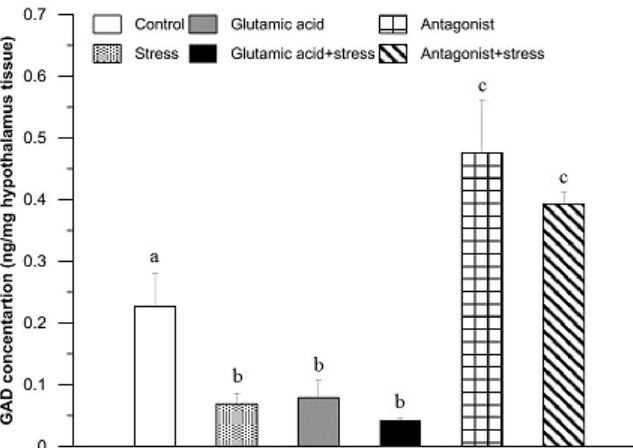
Figure 2. The effect of glutamic acid, stress, and glutamic acid receptor antagonist and their combinations with stress on the concentration of glutamic acid decarboxylase in the rabbit hypothalamus. Values are means ± SEM ( n = 7). Values marked with different letters differ significantly at p < 0.05–0.01.